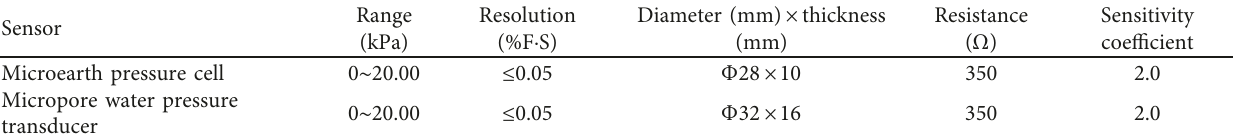
Figure 1: Measuring Table 1: Parameters of the sensors.